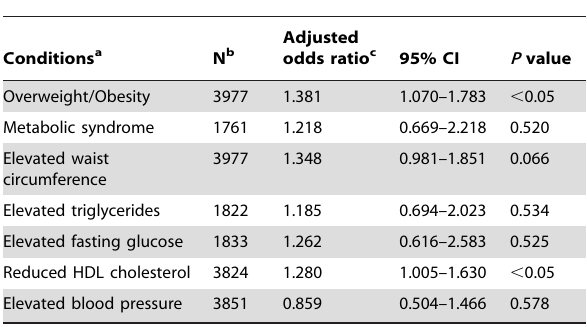
Table 2. Adjusted odds ratio of having certain conditions related to body weight status and metabolic syndrome and its 95% confidence interval: non-consumers vs soup consumers in NHANES